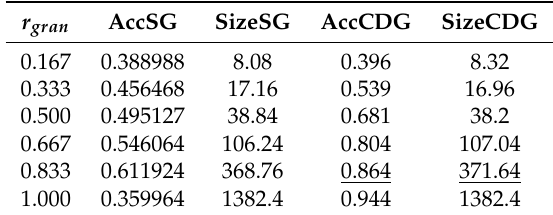
Table 12. Exemplary result for Standard vs. Concept-Dependent Granulation—5 times Cross Validation 5; Car Evaluation data set; r gran = Granulation radius, AccSG = Accuracy of classification for Standard Granulation, AccCDG—Accuracy for Concept-Dependent Granulation, SizeSG = Granular decision system size for Standard Granulation, SizeCDG = Granular decision system size for Concept-Dependent